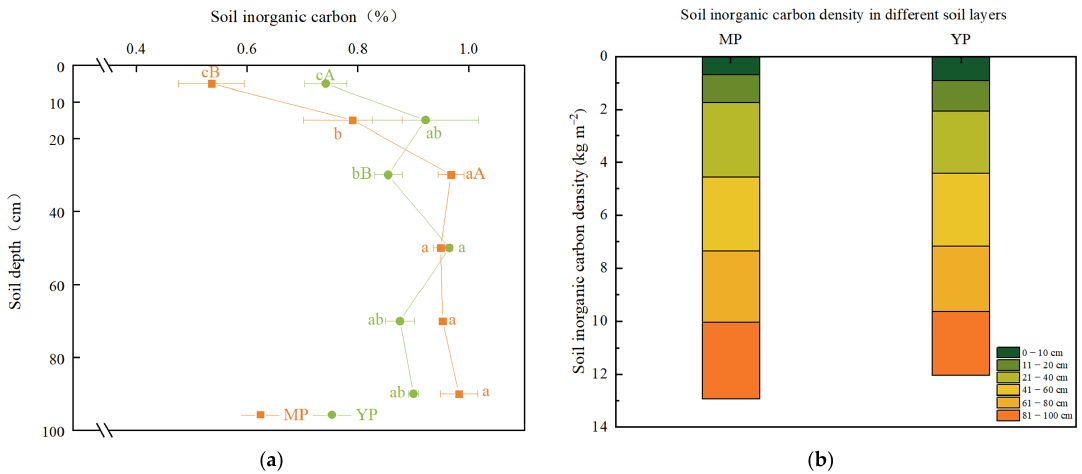
Figure 3. Changes of soil inorganic carbon ( a ) and soil inorganic carbon density ( b ) along 0–100 cm soil profiles in the mature (MP) and young poplar (YP) plantations. Different lowercase letters denote significant differences among different depths within the same plantation; while different uppercase letters denote significant differences between different plantations within the same soil depth ( p < 0.05).